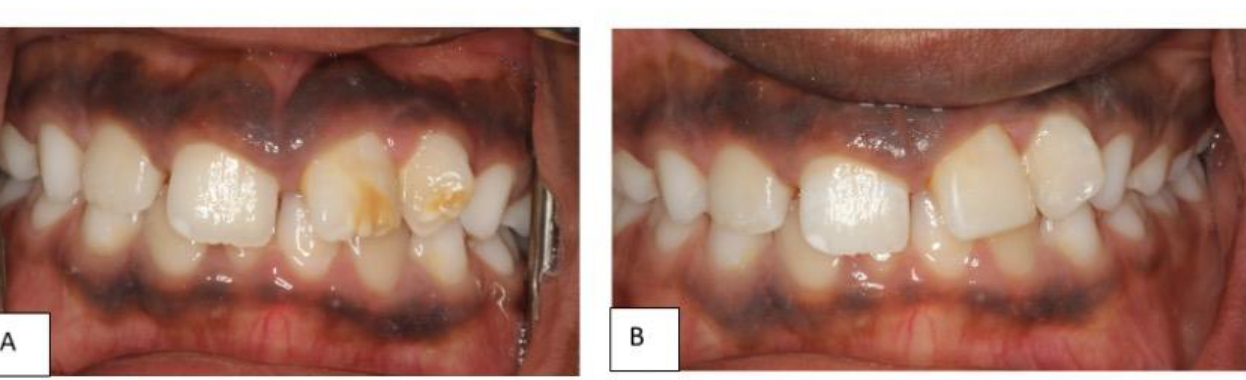
Figure 5. ( A ) the patient’s teeth at a 2-year follow up showing almost complete eruption of upper incisors. ( B ): the hypoplastic teeth after restoration with direct resin composite.